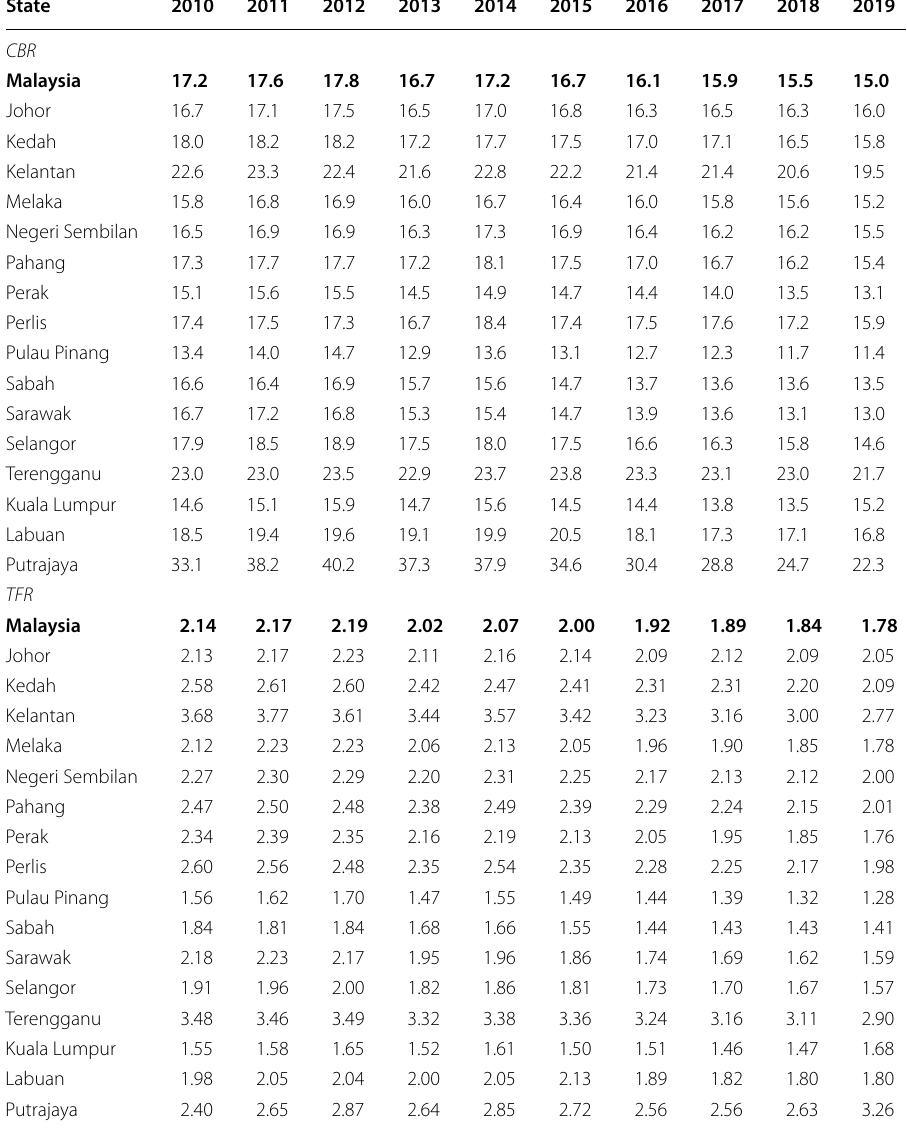
Table 2 CBR and TFR by state in Malaysia,